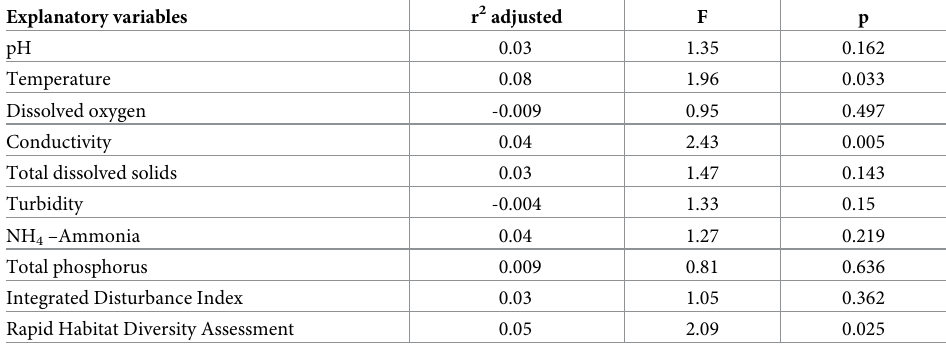
Table 2. Relationships between species composition and explanatory variables in all streams based on distance- based redundancy analysis